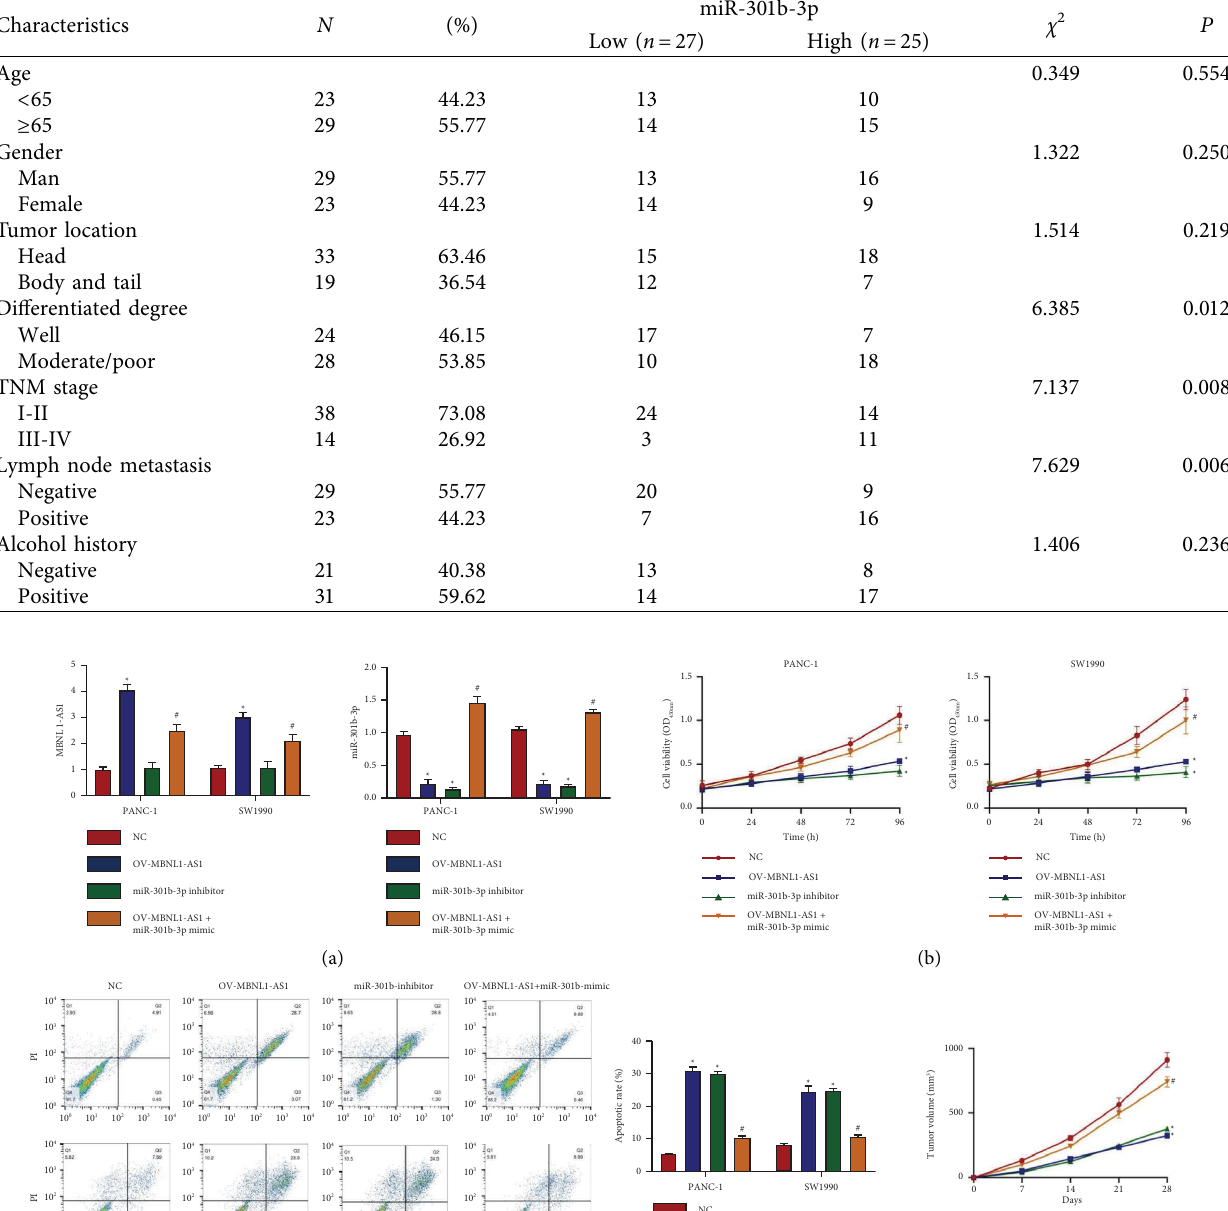
Table 2: Relationship between miR-301b-3p and clinicopathological characteristics of